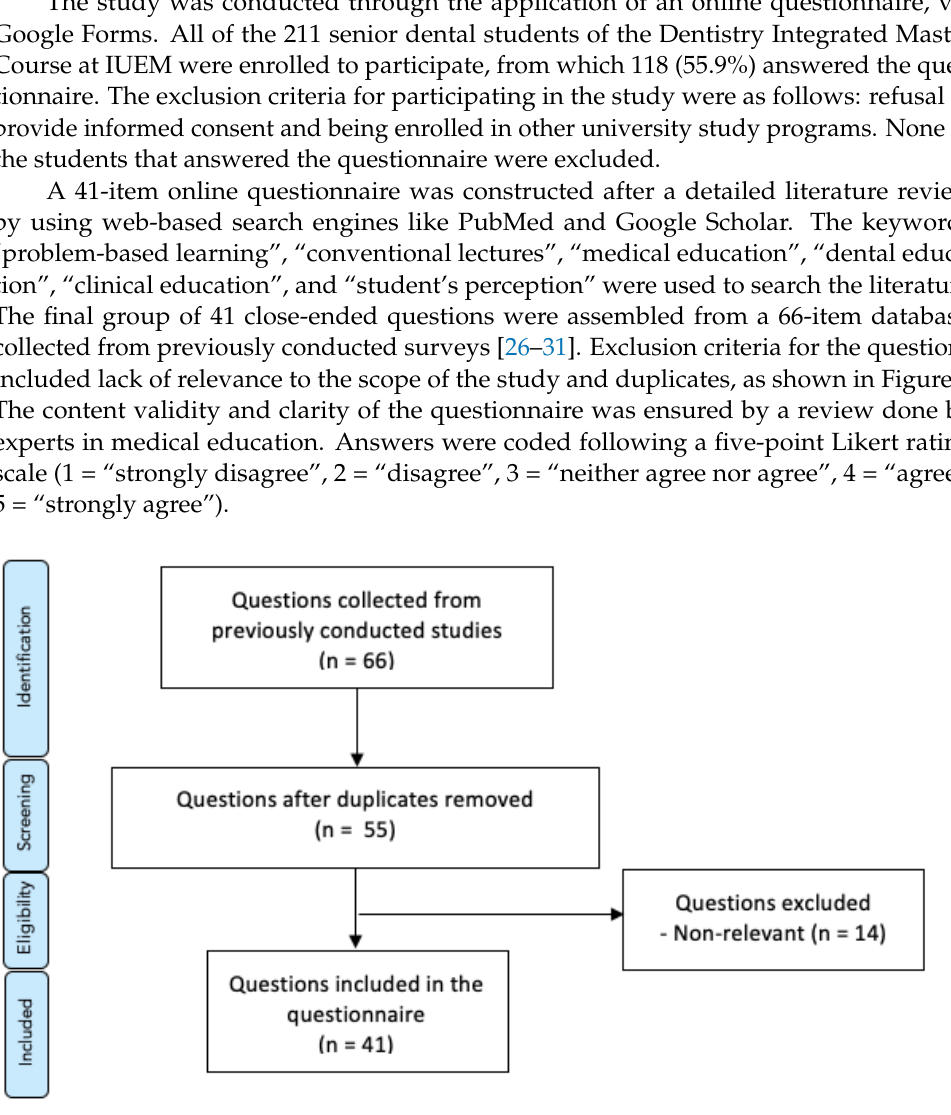
Figure 2. Preferred Reporting Items for Systematic Reviews and Meta-Analyses ( PRISMA) flow chart. Presentation of the procedure of question selection with number of questions at each stage.